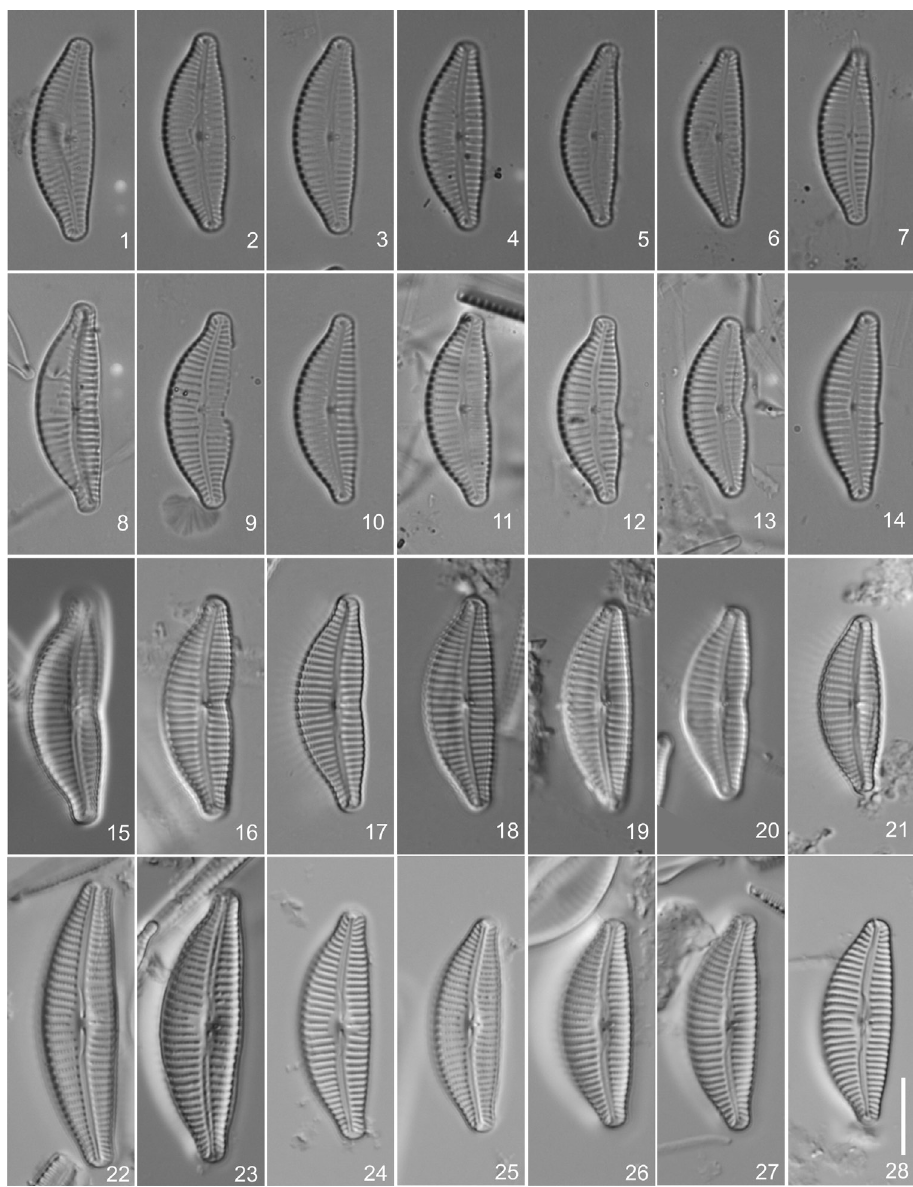
Figures 1–28. Cymbella affinis species complex 1–7 C. affinis Kütz. var. affinis 8–14 C. affinis var. excisa (Kütz.) Grunow, specimens from Trieste in preparation BM 18543 11 Lectotype, designated here 15–21 C. affinis var. excisa [– C. excisa sensu Krammer], specimens from Trieste in preparation 1131 IOK 16 Isolectotype, designated here 22–28 C. affinis var. neoprocera W.Silva, specimens from Germany in preparation 212A IOK, holotype 22 Lectotype, designated here. Scale bar: 10